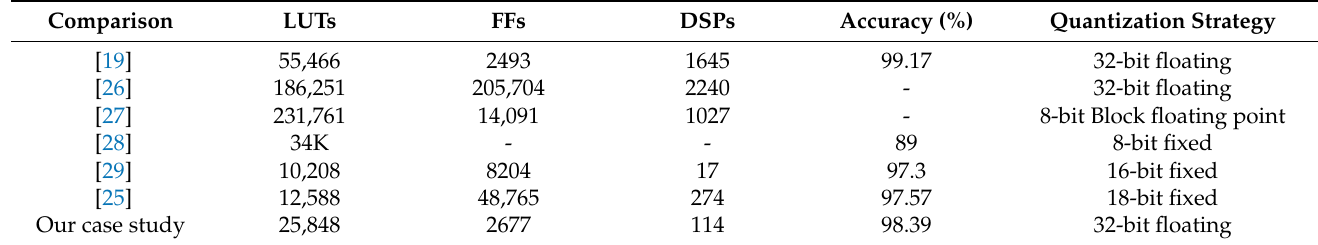
Table 4. Comparison with prior